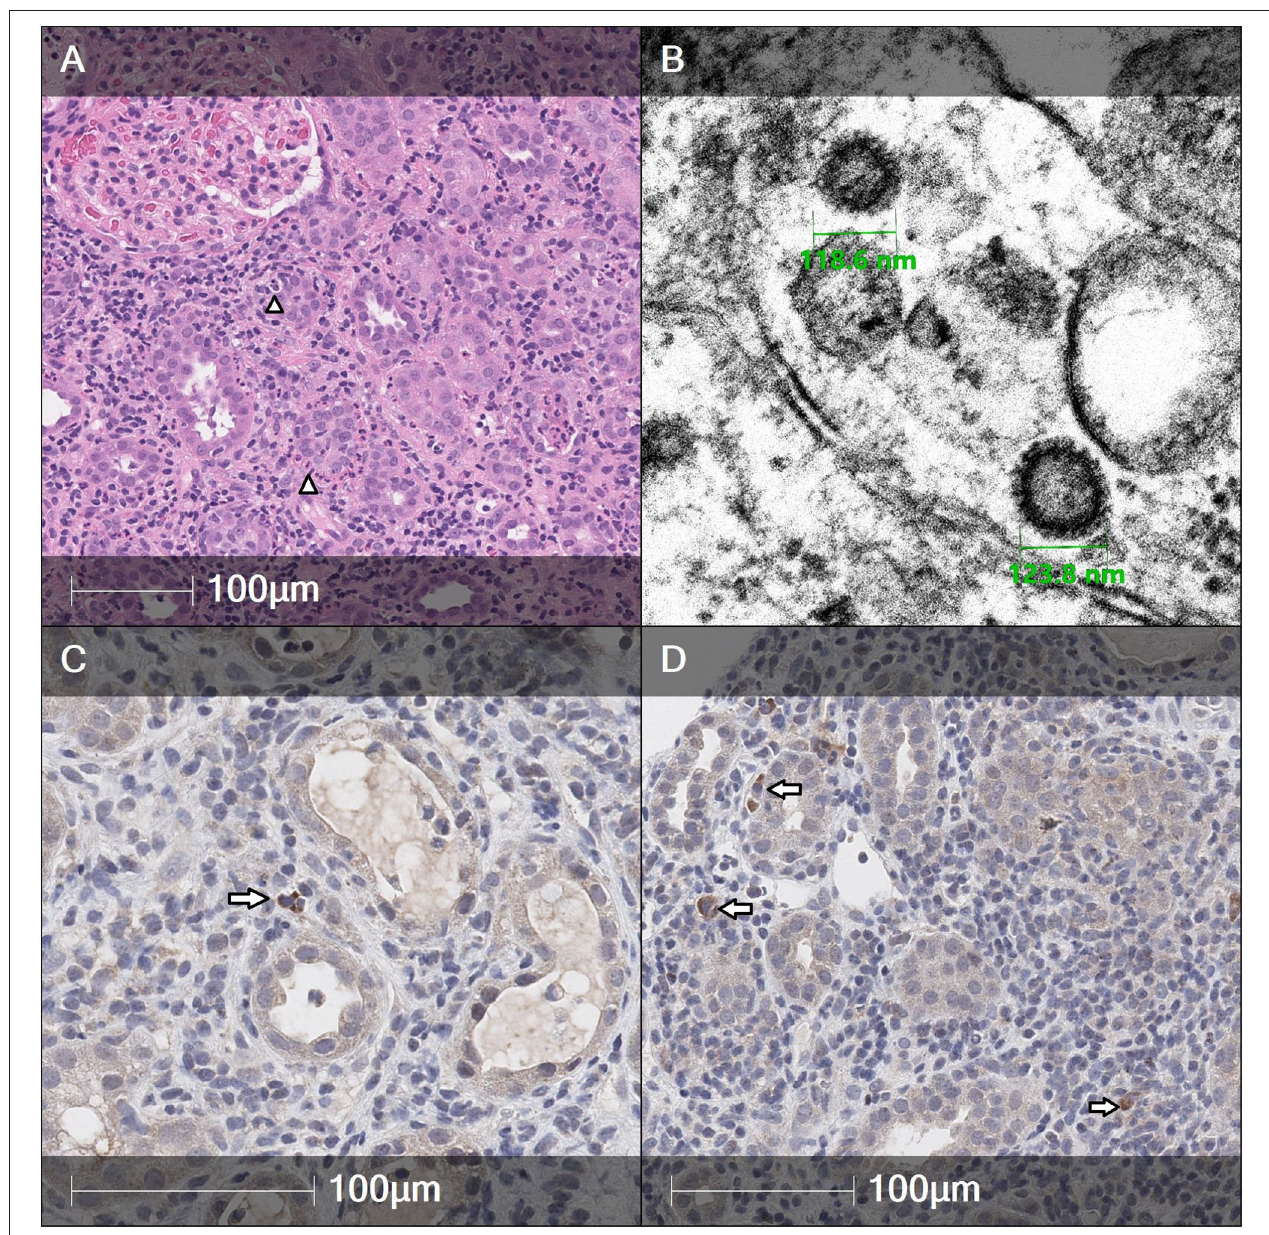
FIGURE 1 | Histological features of kidney biopsy showing diffuse active tubulointerstitial nephritis. (A) H&E slide. Marked lymphocytic infiltration in the interstitium with an admixture of neutrophils and plasma cells. Focal features of acute tubulitis are also present (arrowheads). Glomeruli reveal no apparent histological changes. (B) Electron microscopy sample is taken from interstitium between renal tubules. Few virus-like particles in size of ∼ 120nm with barely visible spikes are present intracellularly. Cross-sections of the particles contain interior electron-dense black dots which could be interpreted as helical nucleocapsid (lower magnification is available in Supplementary Figure 1 ). (C,D) Immunohistochemistry (IHC) for Anti-SARS-CoV-2 spike glycoprotein highlighted positive scattered immune cells in the interstitium of renal parenchyma (arrows). Rabbit polyclonal antibody against severe acute respiratory syndrome coronavirus 2 (SARS-CoV-2) spike glycoprotein (ab272504, Abcam) was applied. Lung tissue of a deceased COVID-19-infected patient was used as a positive tissue control and a negative reagent control was performed on a consecutive biopsy tissue section to ensure sensitivity and specificity of the IHC test.